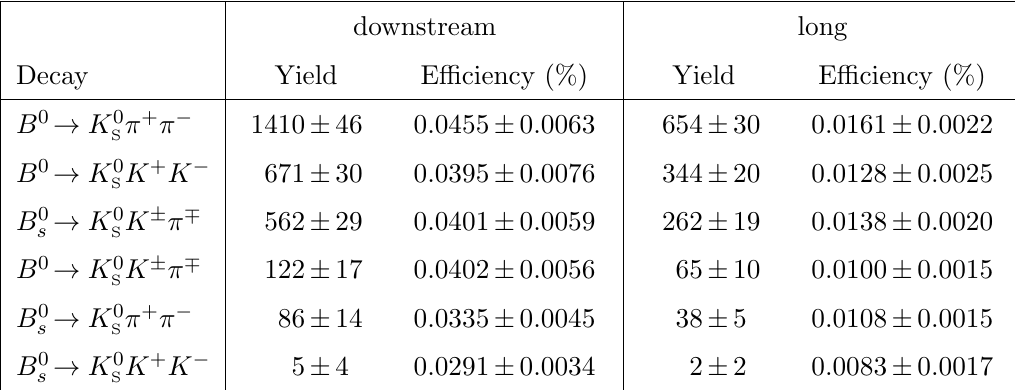
Table 5 . Signal yields obtained for the 2011 category from the simultaneous (cid:12)t to the data. The yields shown are those obtained when (cid:12)tting the data sample selected using the BDT optimisation chosen for the given decay mode. The uncertainties are statistical only. The average selection e(cid:14)ciencies, described in section 5, are also shown for each decay mode together with the corre- sponding total uncertainty due to the limited simulation sample size and systematic e(cid:11)ects in their